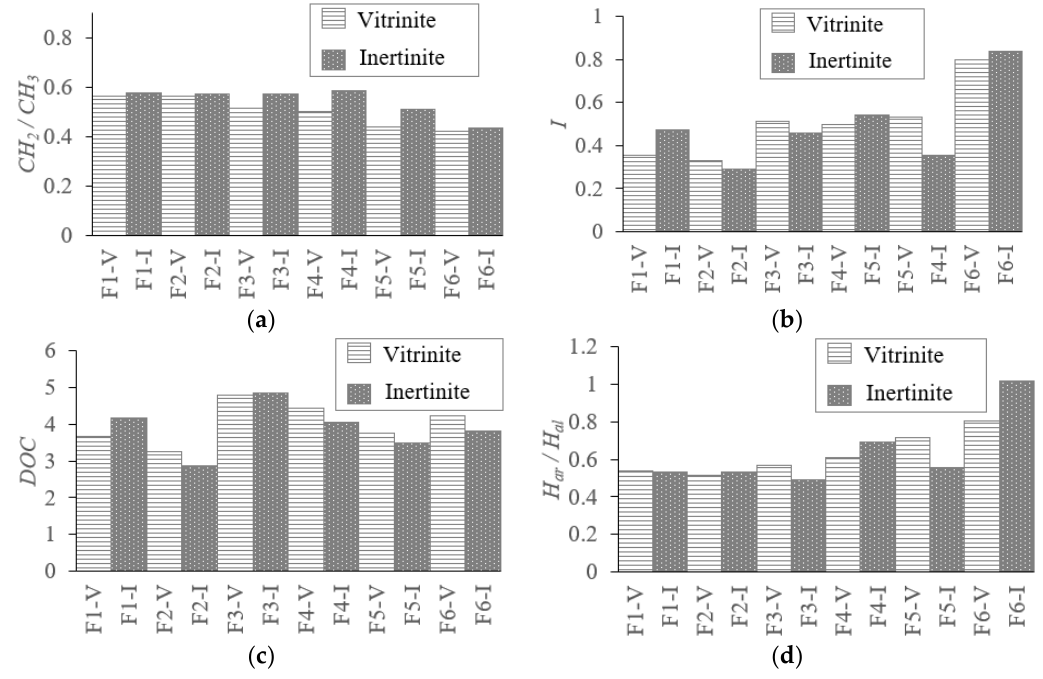
Figure 12. FTIR structure parameters of samples (( a – d ), are the distributions of CH 2 / CH 3 , I , DOC , and H ar / H al , respectively). CH 2 / CH 3 represents the length of aliphatic side-chains; I represents the aromatic degree; DOC represents the polycondensation degree of the aromatic rings; H ar / H al represents the relative abundance of aromatic to aliphatic